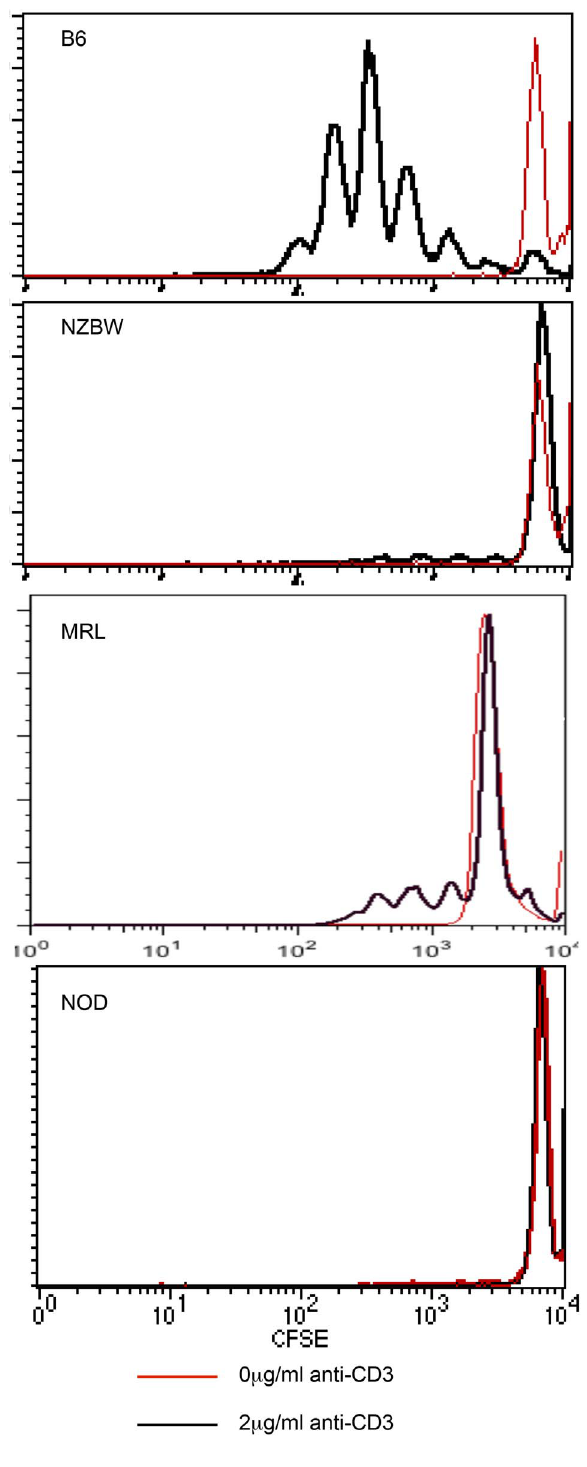
Figure 4. B lymphocytes are required for proliferation of T cells in autoimmune prone lineages. Splenocytes harvested from B6, NOD, MRL, or NZBW were depleted of B cells by MACS with anti-B220 antibodies. The resultant populations were stimulated with 2 m g/ml anti-CD3 and 2 m g/ml anti-CD28 for 65 hours (black histogram) or left unstimulated (red histogram). At that time, minimal proliferation was detected in B cell depleted cultures in autoimmune-prone mice whereas B6 splenocytes maintained normal proliferation in the absence of B cells. Data are representative of three to four separate experiments. doi:10.1371/journal.pone.0106347.g004 PLOS ONE |